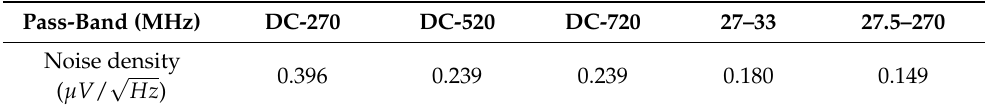
DC-coupling low-pass RF filters (Figure 8 right) are noisy, resulting from high 1/ f noise.